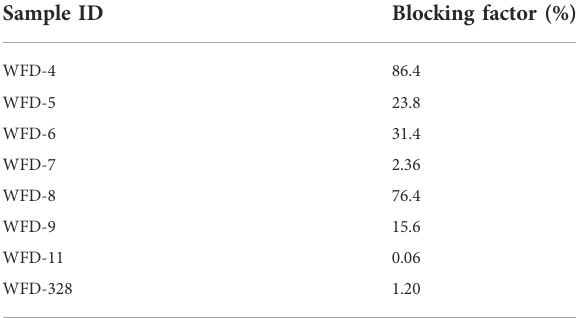
TABLE 7 Blocking factors of the eight Woodford Shale